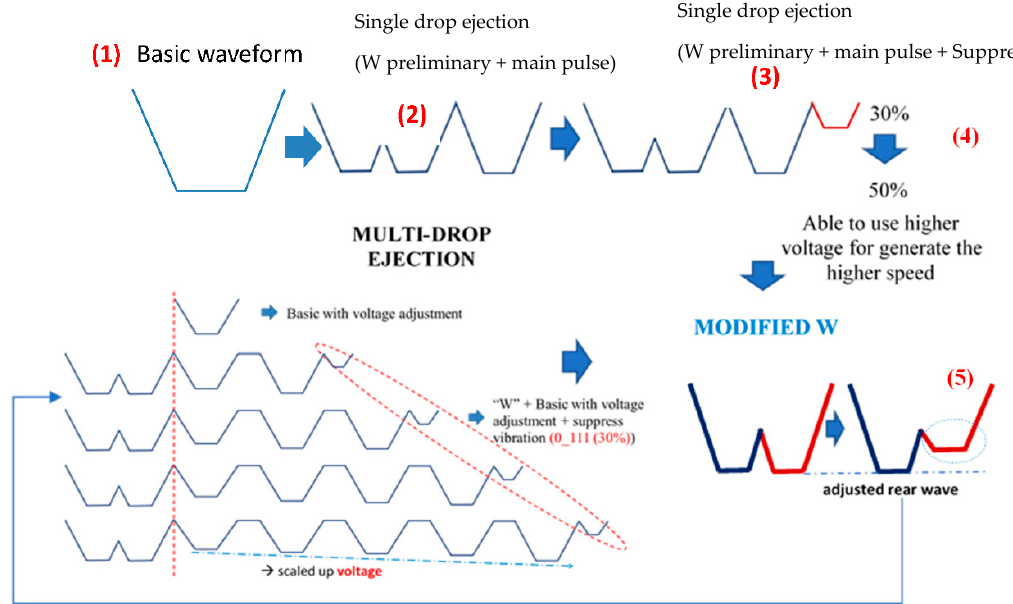
Figure 8. Concept of waveform design optimization.